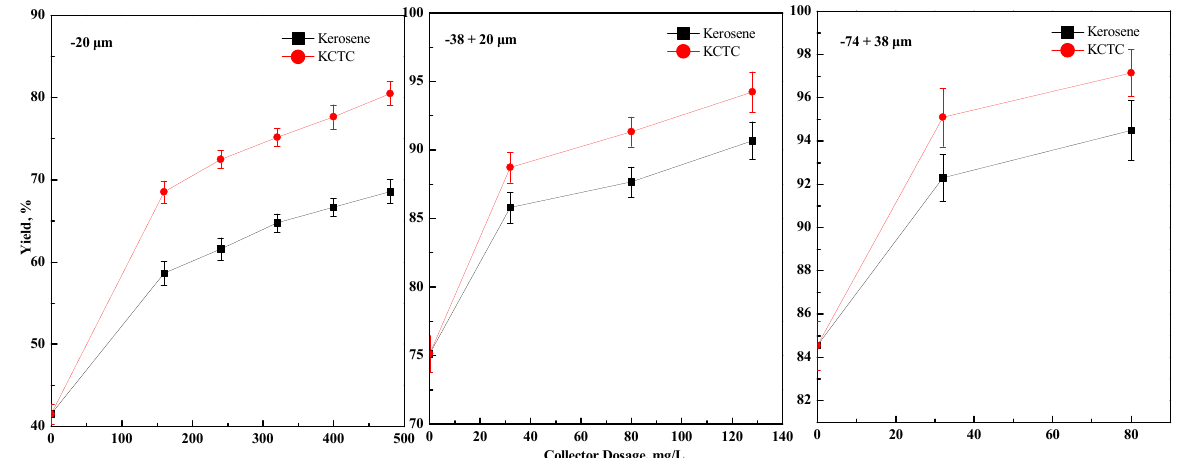
Figure 11. Flotation performance of kerosene and KCTC, regarding the flotation of molybdenite particles of different sizes.